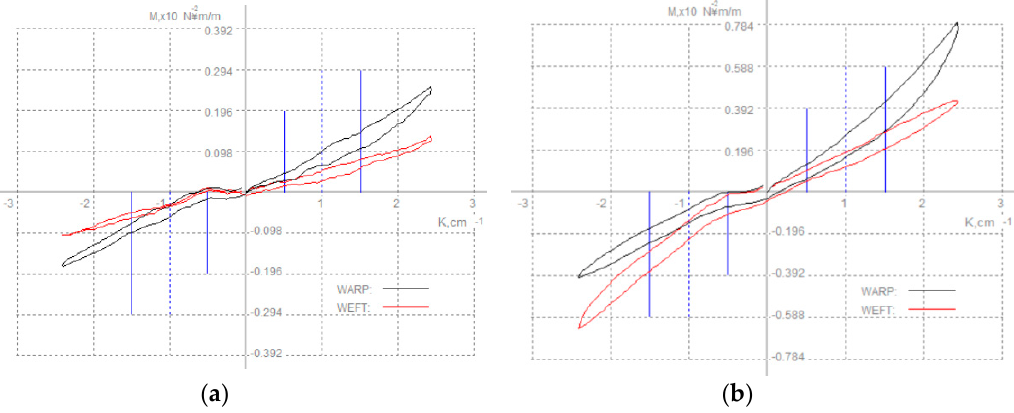
Figure 10. Bending property